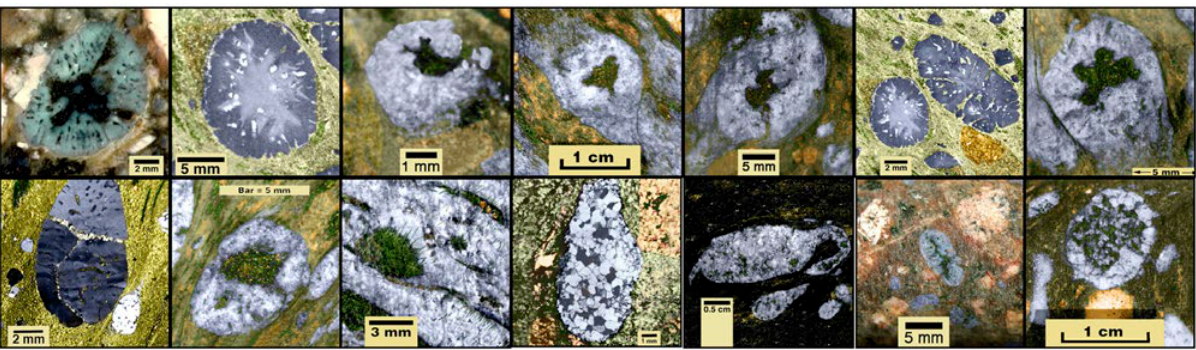
Figure 63. Polymeric silica accretions from Great Western porphyroid, Tennant Creek, have crystallised to quartz.